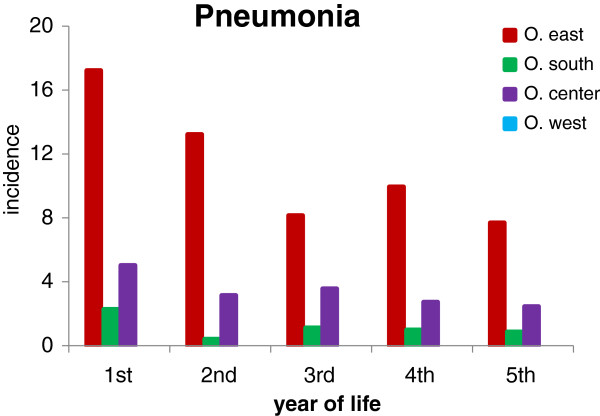
Incidence of pneumonia per 100 children per year of life. Numbers of children stratified by age and region of residence are presented in Table 3. In O. west there was only 1 case of pneumonia in the 1st and another one in the 5th year.